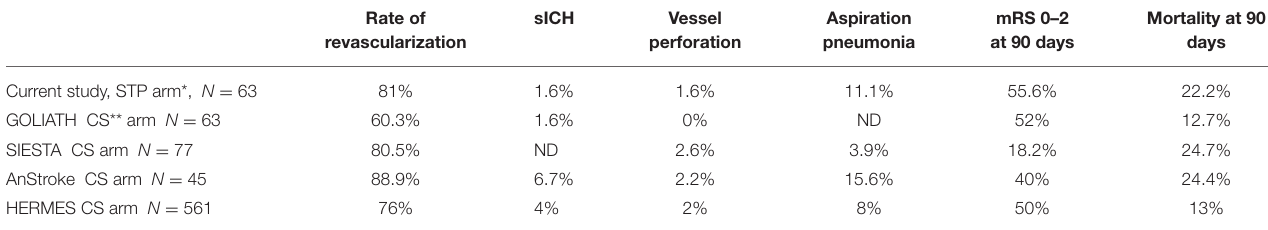
TABLE 3 | Conscious sedation arms of recent MT clinical